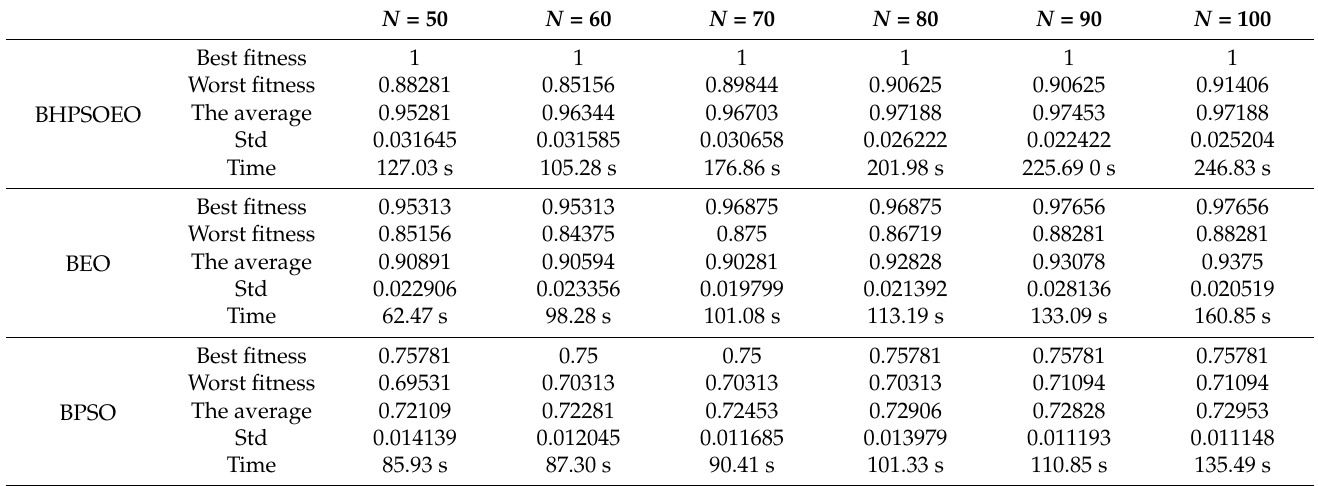
Table 3. BHPSEO, BEO and BPSO numerical results for cryptanalysis of the RC4 cipher of a 128-bit text length.